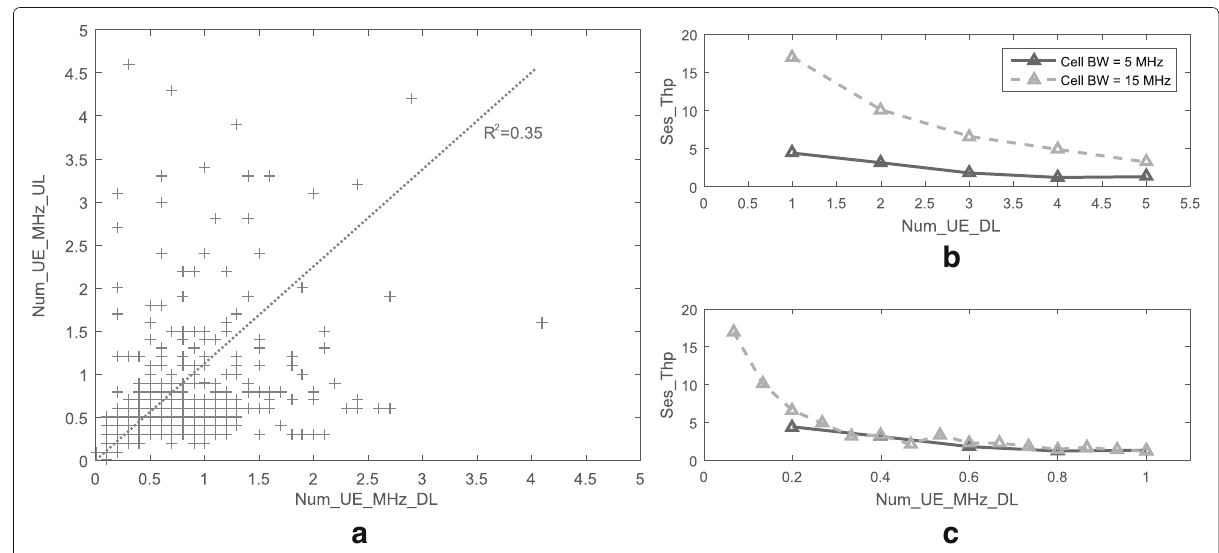
a Fig. 2 Analysis of the mean number of active UEs in a cell: a Correlation between the downlink and uplink. b , c Impact of the cell bandwidth user throughput and support higher number of users.